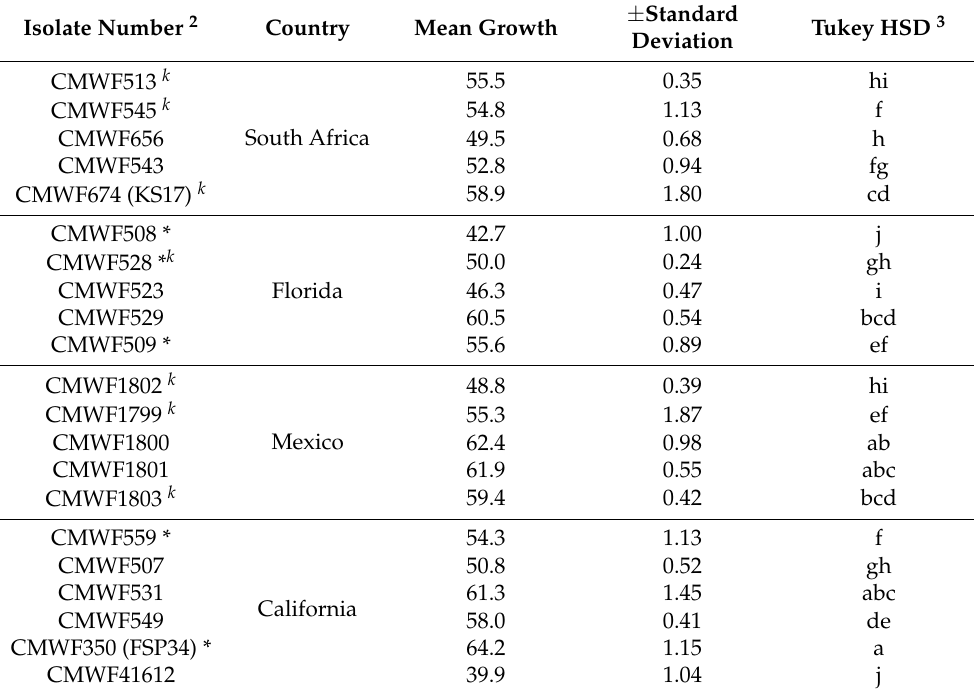
Table 2. Mycelial growth of genetically and geographically diverse isolates of F. circinatum on pine-based growth medium 1